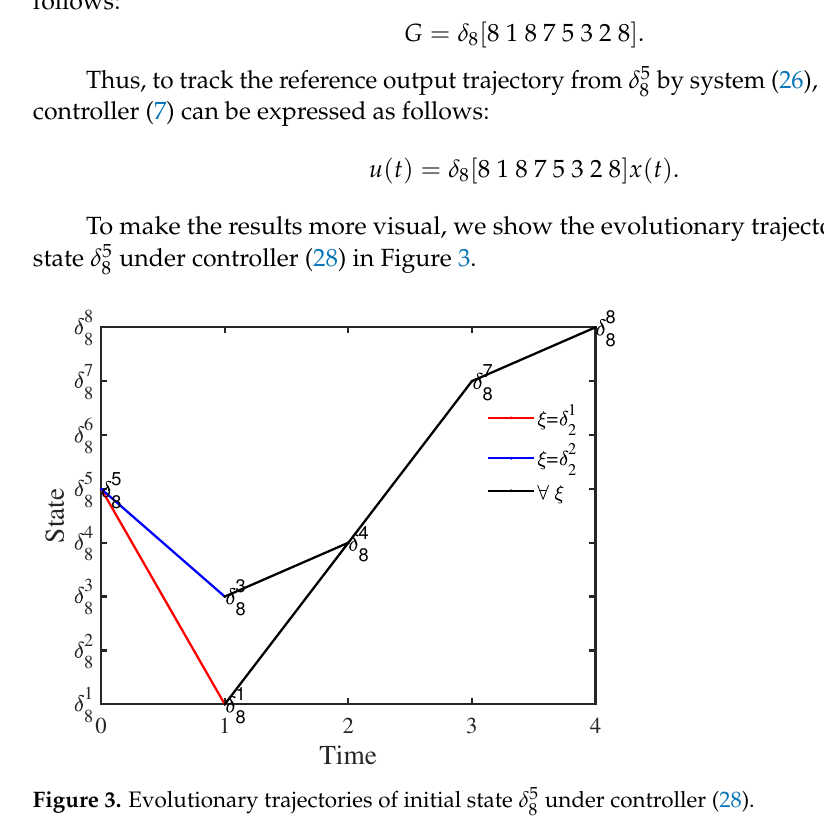
under controller 8